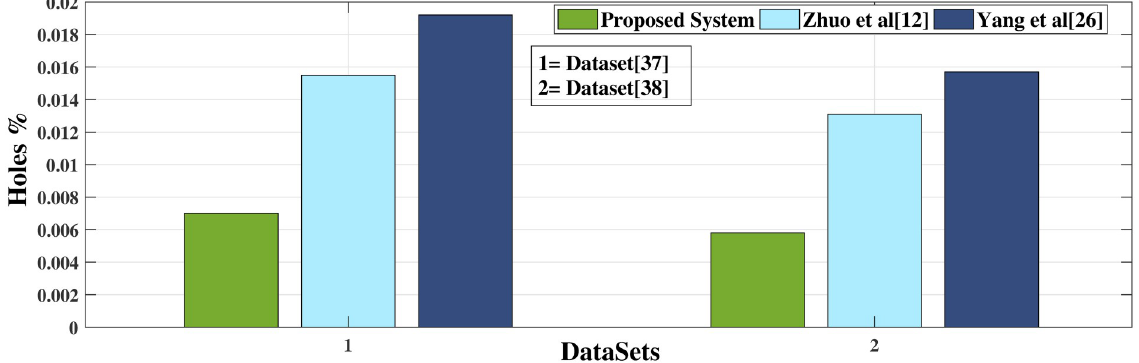
Fig 16. Holes percentage of occluded